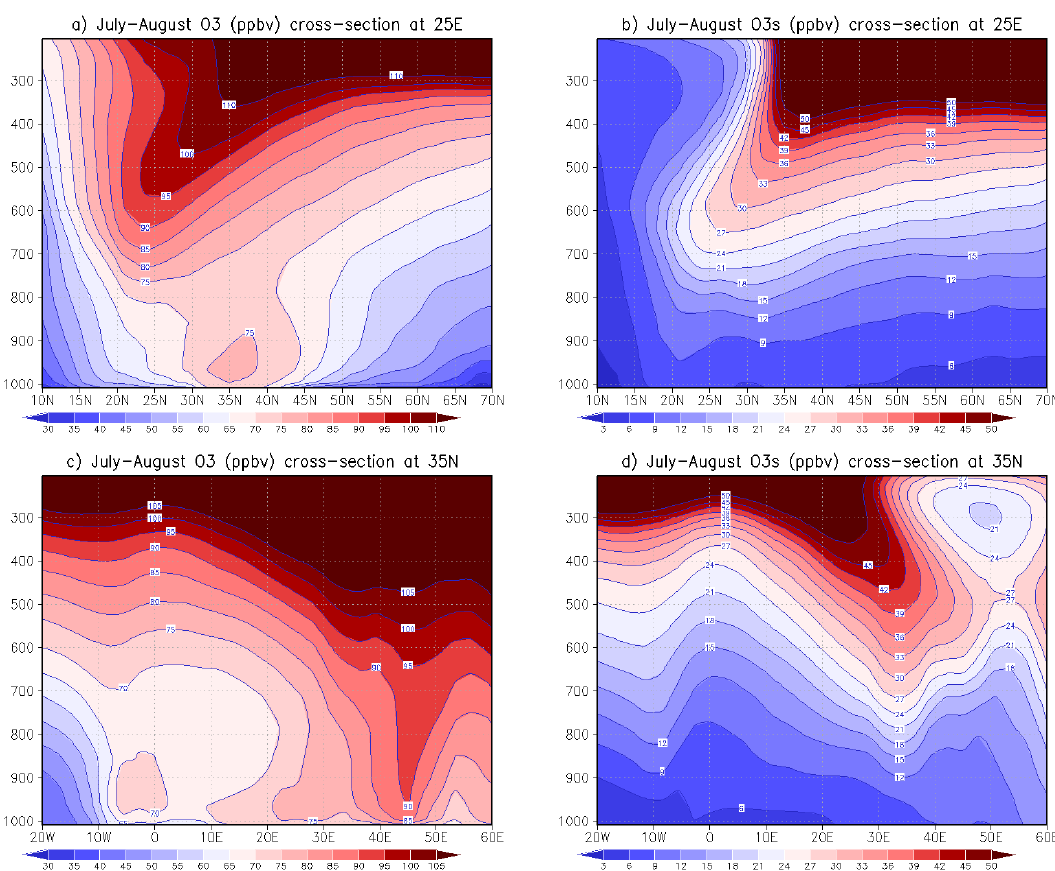
Fig. 7. Upper plates: EMAC July–August latitude–pressure cross sections at 25 ◦ E longitude of simulated (a) ozone (ppbv) and (b) strato- spheric ozone tracer O3s (ppbv) averaged over the period 1998–2009. Bottom plates: EMAC July–August longitude–pressure cross sections Figure 7. Upper plates: EMAC July-August latitude-pressure cross sections at 25°E 920 at 35 ◦ N latitude of (c) ozone (ppbv) and (d) stratospheric ozone tracer (ppbv) averaged over the period 1998–2009. longitude of simulated a) ozone (ppbv) and b) stratospheric ozone tracer O3s (ppbv) 921 The EMAC-simulated ozone in the lower free troposphere averaged over the period 1998-2009. Bottom plates: EMAC July-August longitude- 922 (714 hPa) illustrates a summer maximum over the EM sta- tions at Cyprus (CY02) and Crete (GR02) peaking in July– pressure cross sections at 35°N latitude of c)ozone (ppbv) and d) stratospheric ozone 923 August and broad spring–summer maximum at Gozo, Malta (MT01), over the central Mediterranean and Cabo de Creus, tracer (ppbv) averaged over the period 1998-2009. 924 Spain (ES10), over the western Mediterranean (Fig.